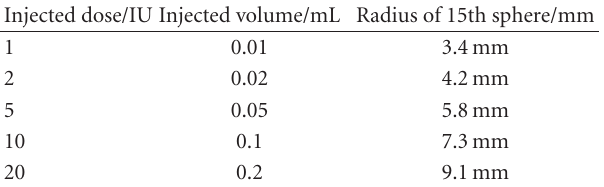
Table 4: Radius of the 15th sphere for various injected volumes of U100 (100mIU/L)